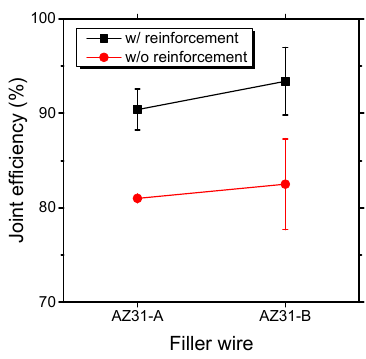
Figure 5. Joint efficiency for BOP welding.